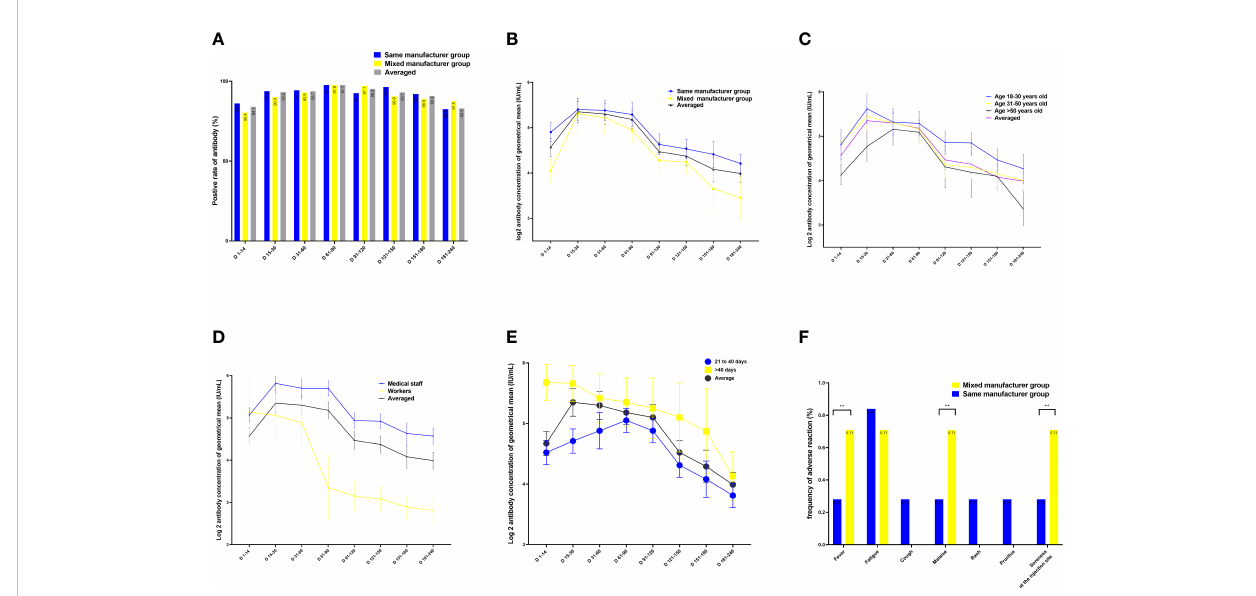
FIGURE 2 Quantitation of antibodies on days 1 – 240 following administration of the Chinese inactivated vaccine. (A) Positive rates of neutralizing antibodies. ( B – E ) Kinetics of neutralizing antibodies according to (B) vaccination type, (C) age, (D) occupation, and (E) sex. (F) Comparison of adverse effects between individuals vaccinated with vaccines from the same and different manufacturers for the two doses. Data are presented as mean (95% con fi dence interval [CI]) from the linear mixed-effects model adjusted for vaccine manufacturer, sex, blood type, age, occupation, and BMI. The log 2 -transformed level of neutralizing antibodies was used as the independent variable. BMI, body mass index; LSMD, least-square mean difference.